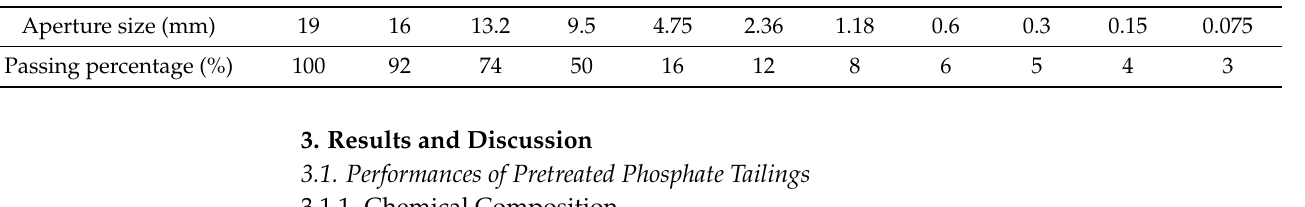
Table 2. OGFC-16 asphalt mixture mineral gradation.